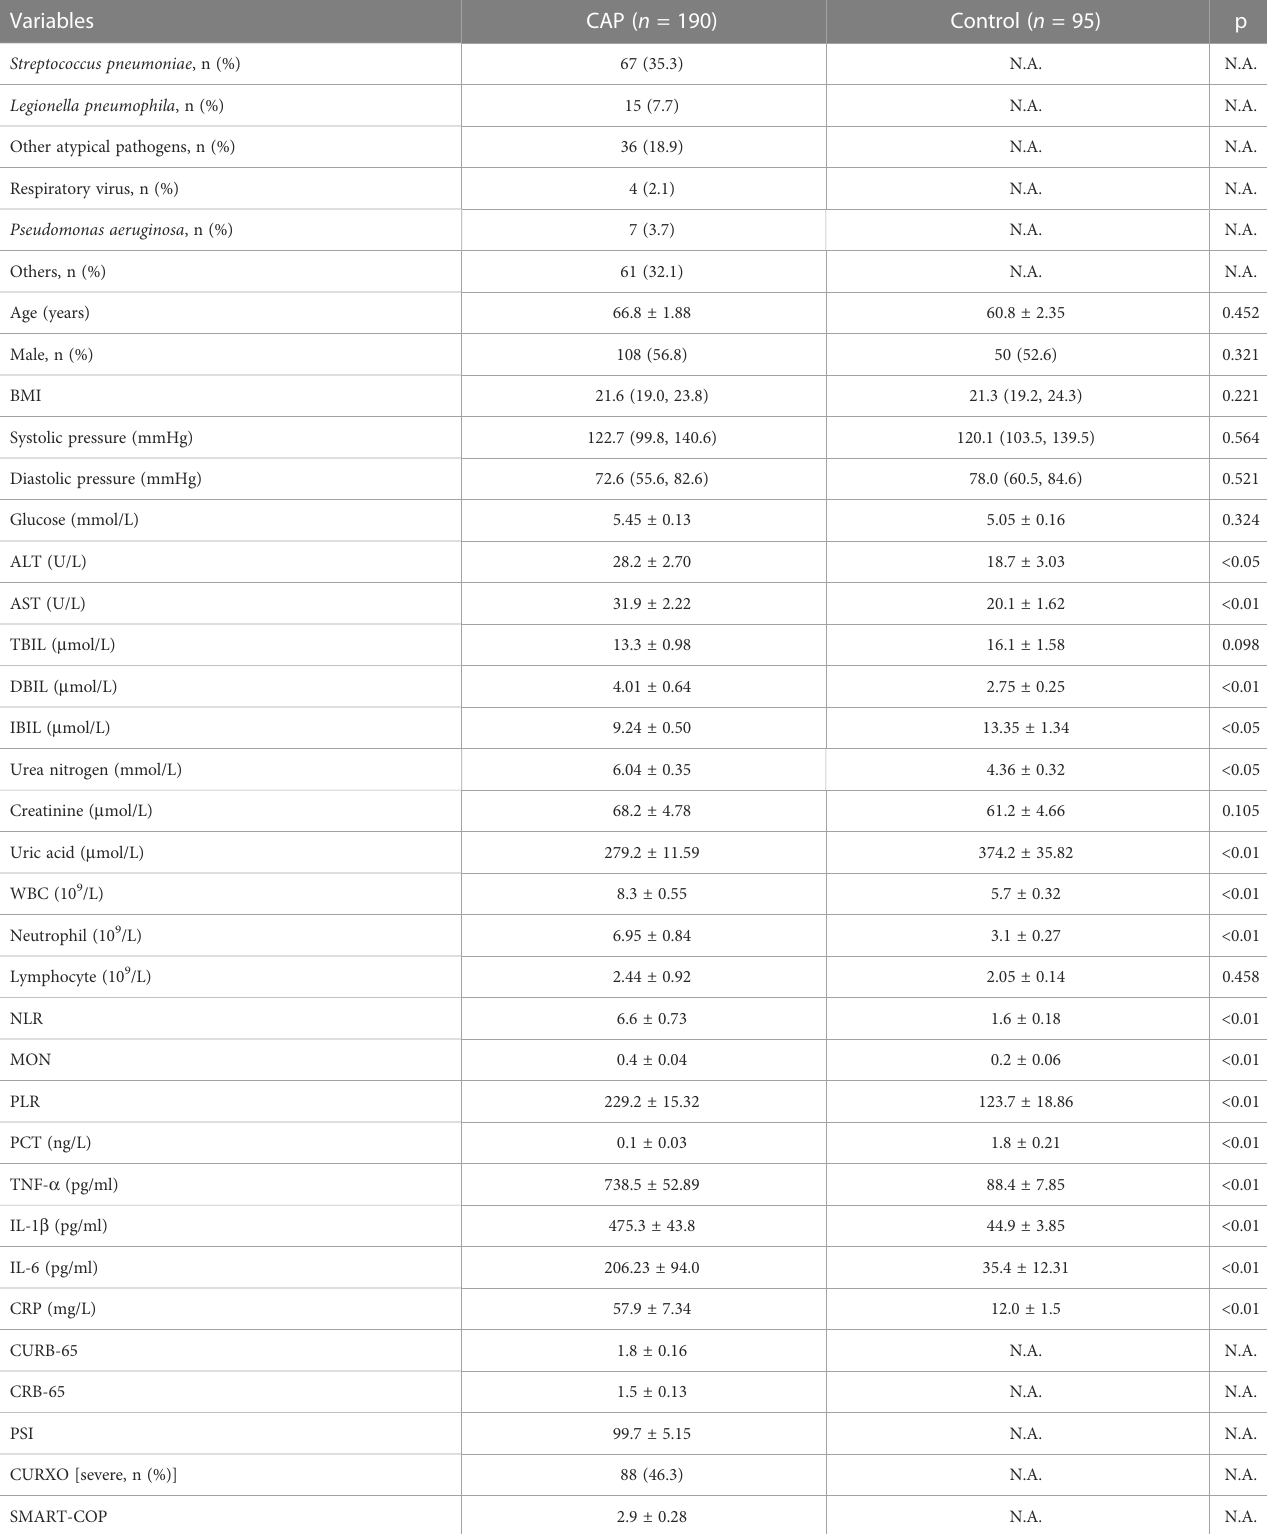
TABLE 2 Demographic and clinical characteristics between CAP patients and control subjects.